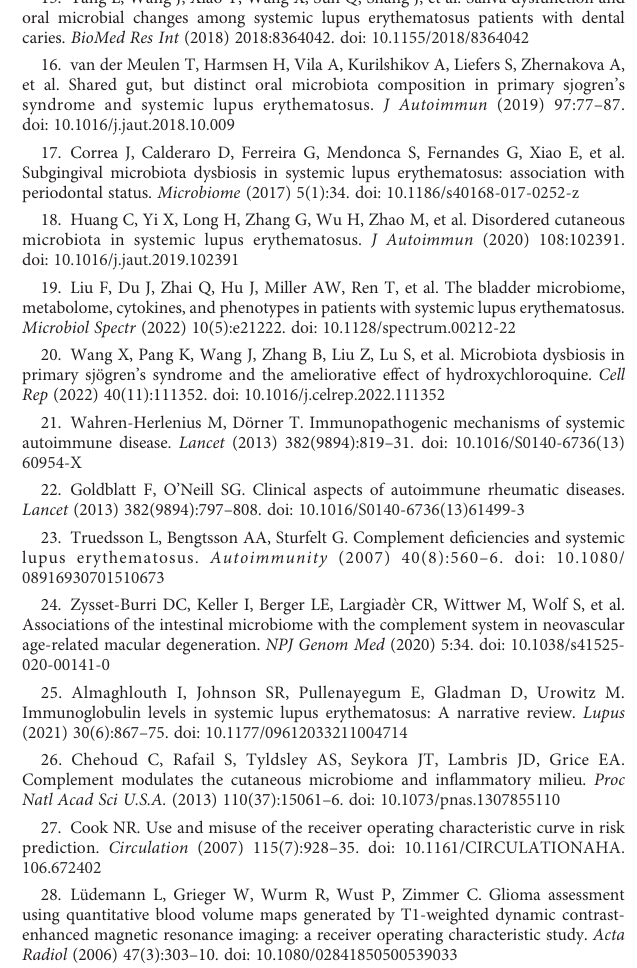
SUPPLEMENTARY FIGURE 1 Bacterial composition between the medication users and non-users. (A) Comparison between azathioprine users and non-users. (B) Comparison between hydroxychloroquine users and non-users. (C) Comparison between prednisolone users and non-users. PCoA based on Bray − Curtis distances ASV level. The 95% con fi dence ellipse is drawn for each group. Permutational multivariate analysis of variance (PERMANOVA) was performed for statistical comparisons of samples in the two groups. The P value was adjusted using the Benjamini and Hochberg false discovery rate (FDR). HCF, HC feces; HCV, HC vagina; SLEF, systemic lupus erythematosus feces; SLEV, systemic lupus erythematosus